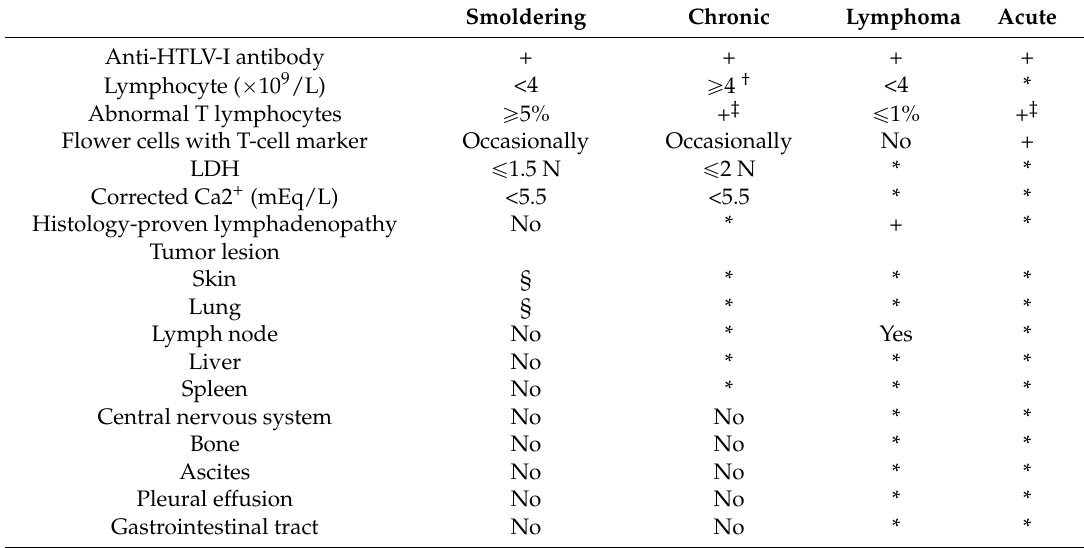
Table 1. Diagnostic criteria and classification (the Shimoyama